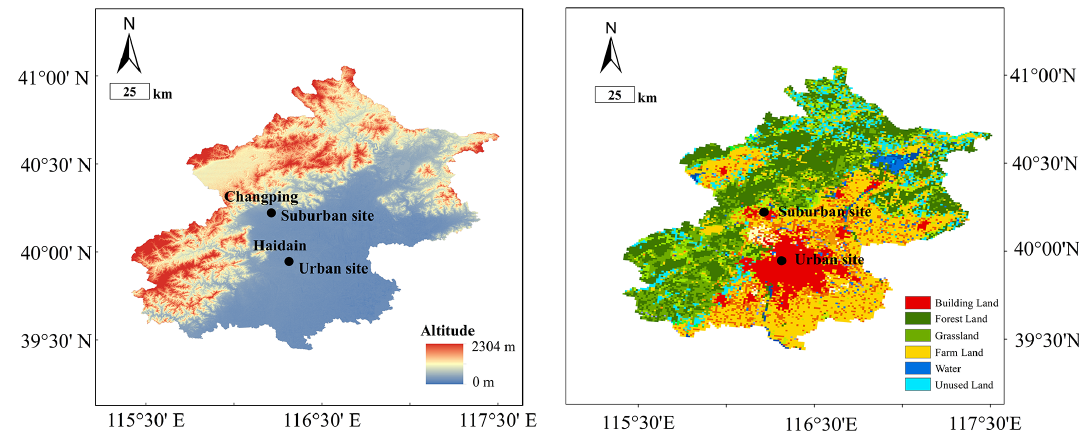
Figure 1. Location of the observation sites, the topography, and the land use for Beijing city.